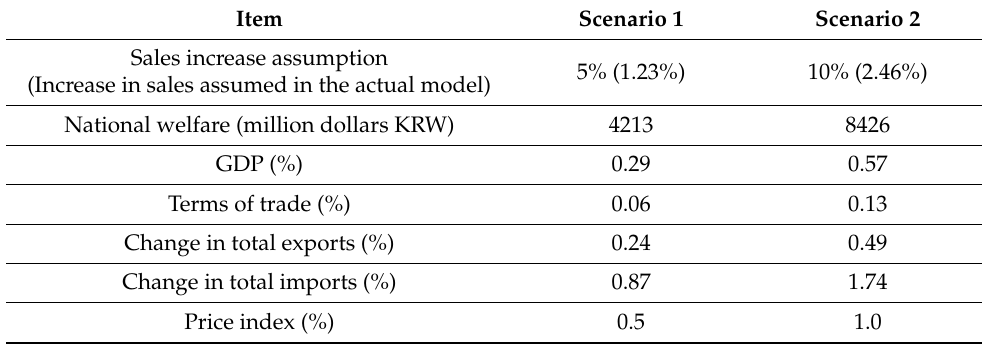
Table 4. The economic impact of HCL on South Korea by GTAP